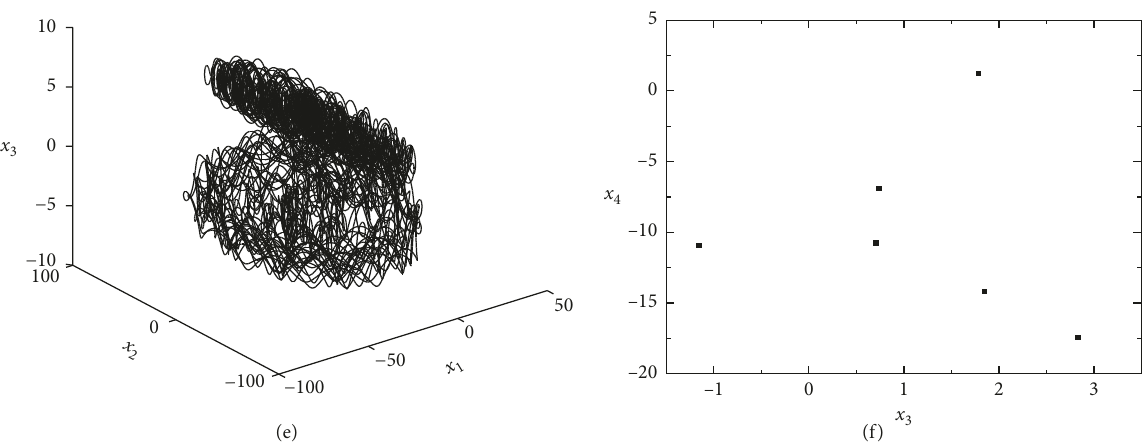
Figure 13: Chaotic motion of the composite shell when f equals 100. (a) Waveform in the plane ( t, x (c) Two-dimensional phase portrait in the plane ( x phase portrait in the plane ( x